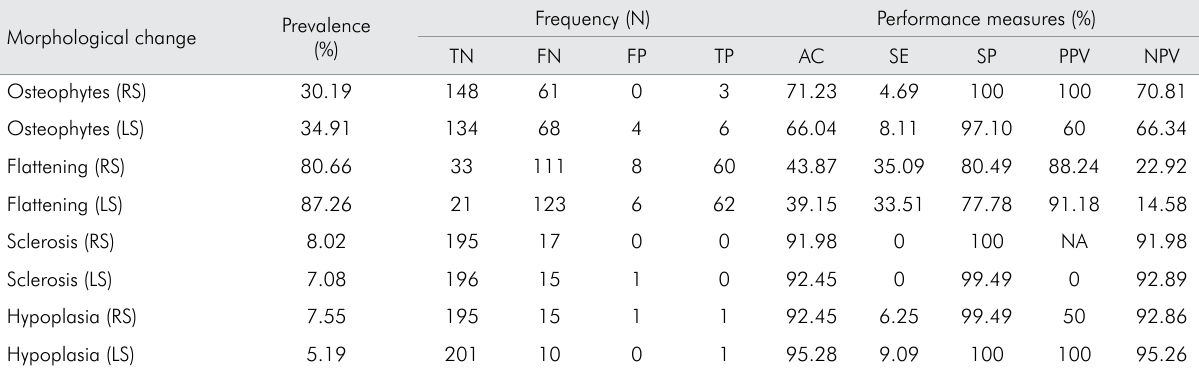
Table 3. Outcomes of the appraisers’ performance to the diagnosis considered as having a high prevalence in the sample. Morphological